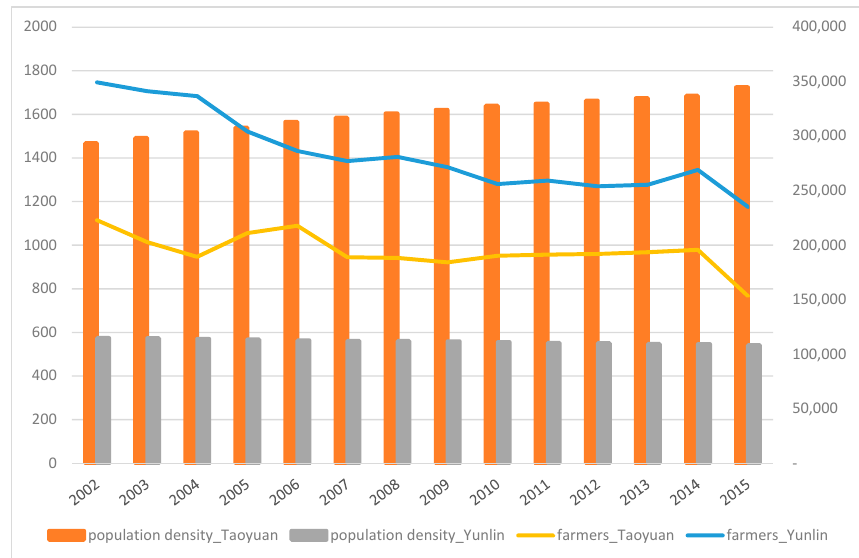
Figure 1. Population density (person per km 2 , left scale) and number of farmers (person, right scale) in Taoyuan and Yunlin, 2002–2014.